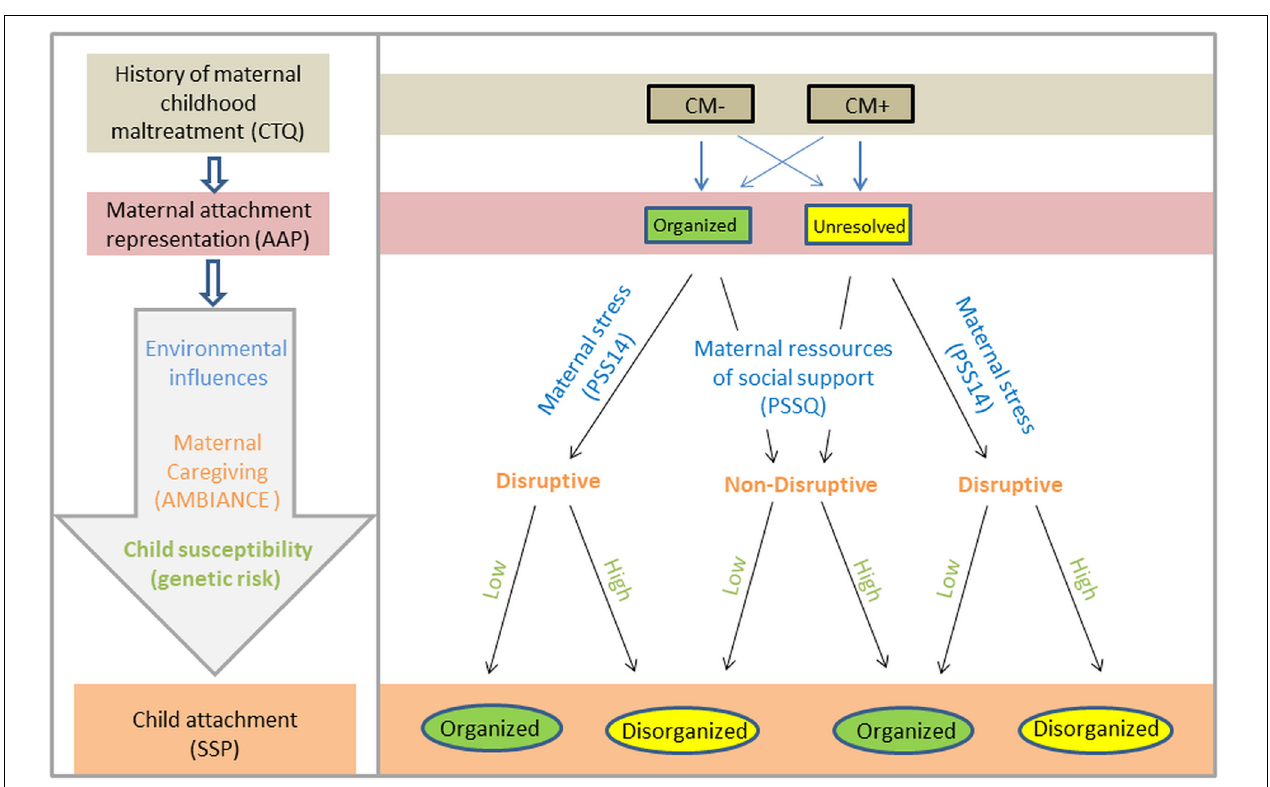
FIGURE 1 | Adapted model from van IJzendoorn and Bakermans-Kranenburg (2019) for the root effects of the intergenerational cycle of maltreatment (ICM) and its effects on the level of attachment in mother-infant dyads. Allelic discrimination of OXTR rs2254298 includes genotypes AA, AG, and GG. At least one A allele is considered a risk genotype for higher stress susceptibility, and a ditochomous analysis (AX vs. GG) was